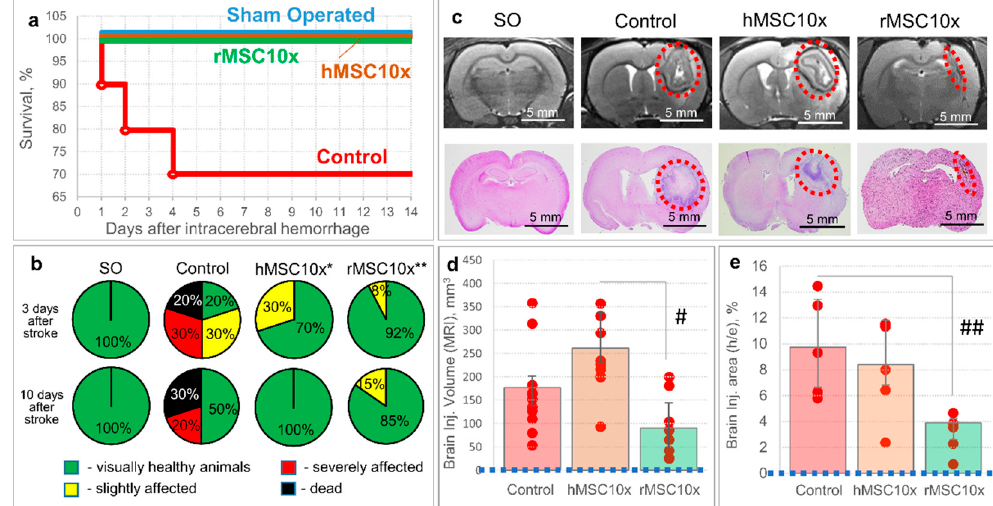
Figure 6. The results of in vivo studies of the neuroprotective activity of the 10 fold-concentrated rat (allogenic) MSC secretome (rMSC10x): ( a ) the dynamics of survival of the experimental animals; ( b ) neurological status of the experimental animals at days three and 10 after the intracerebral hemorrhage (SO—sham operated) [*— p = 0.006, n = 10, two-sided Fisher’s exact test; **— p = 0.0004, n = 18, two-sided Fisher’s exact test]; ( c ) samples of MR images and histological slices of the brains obtained from the experimental animals (the red dashed ovals restrict the injured loci); ( d ) results of the MRI examination of the brain at day 11 after the intracerebral hemorrhage [#—H (2, 21) = 11.033; p = 0.004; n ≥ 8; ANOVA on ranks]; ( e ) results of the histochemical examination of the brain at day 14 after the intracerebral hemorrhage [##—H (2, 12) = 7.580; p = 0.023; n = 5; ANOVA on ranks]. Data is presented as a median (25%; 75%).